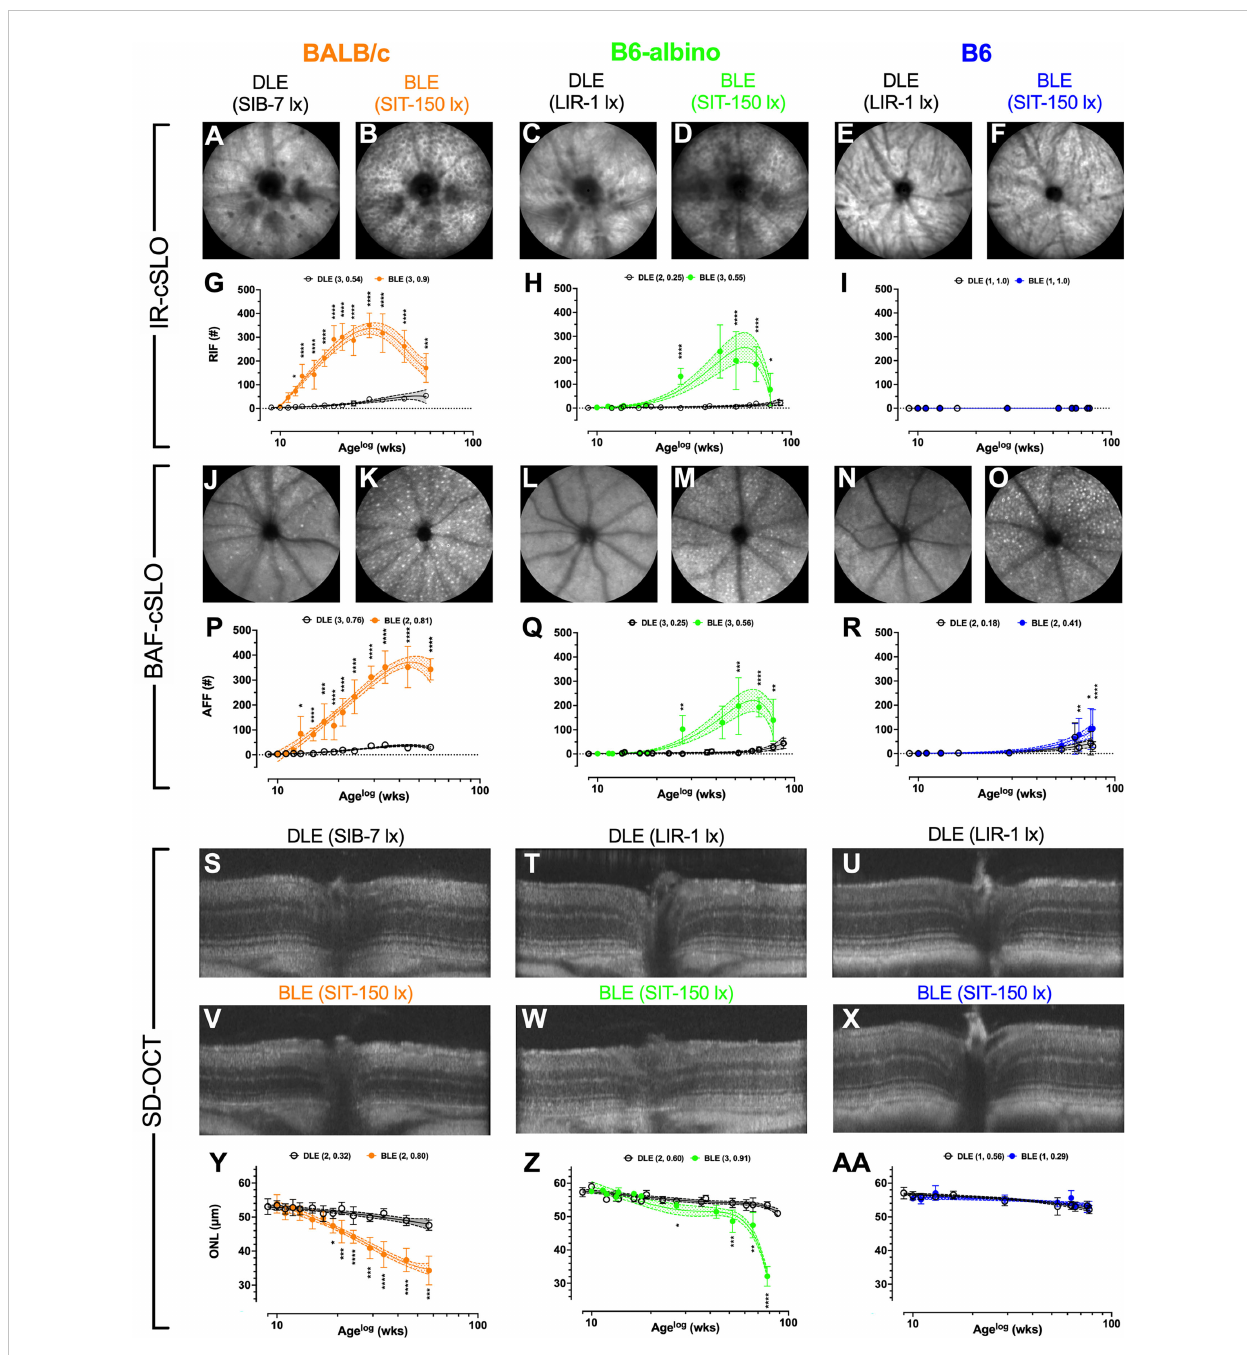
FIGURE 1 Results for Analyses # ’ s 1-3 showing temporal changes in Retinal Infoldings (A – F; G – I) , Auto fl uorescent Foci (J – O; P – R) and Photoreceptor Degeneration (S – X; Y – AA) for BALB/c, B6-albino and B6 mice after chronic exposure to DLE and BLE conditions. BALB/c images are from 24 wks (Age: 33 wks) post exposure onset. B6-albino and B6 mice images are from 57 wks (Age: 66 wks) post exposure onset. Both albino strains developed substantial numbers of RIF which were not observed in pigmented B6 mice. All three strains developed signi fi cant AFF that varied in progression rate relative to light exposure duration. Signi fi cant photoreceptor degeneration was observed in the two albino strains only, with substantially different decay rate behaviors witnessed between the two albino strains as BALB/c and B6-albino exhibited uniphasic and biphasic decays, respectively. BLE and DLE legends display in parenthesis the best fi t polynomial order (i.e. 1, 2, or 3) and R-squared